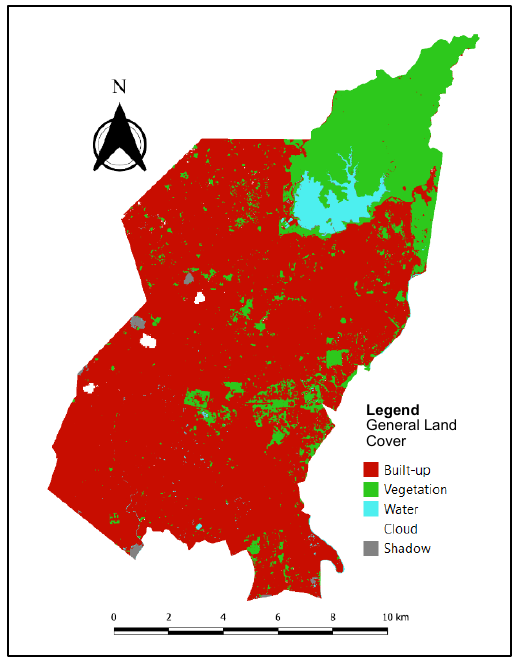
Figure 9. Best-performing Level 1 output (93.17% OA)